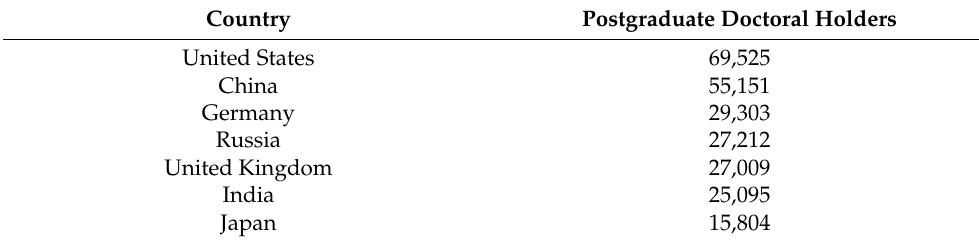
Table 1. Countries with the most postgraduate doctoral holders (OECD